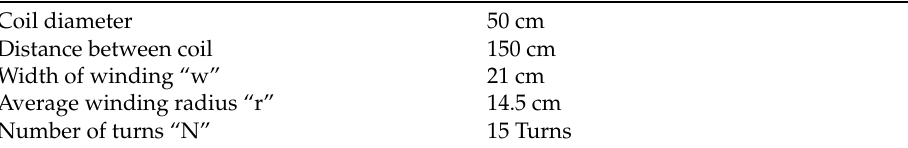
Figure 12. Real prototype for the wireless transfer system.